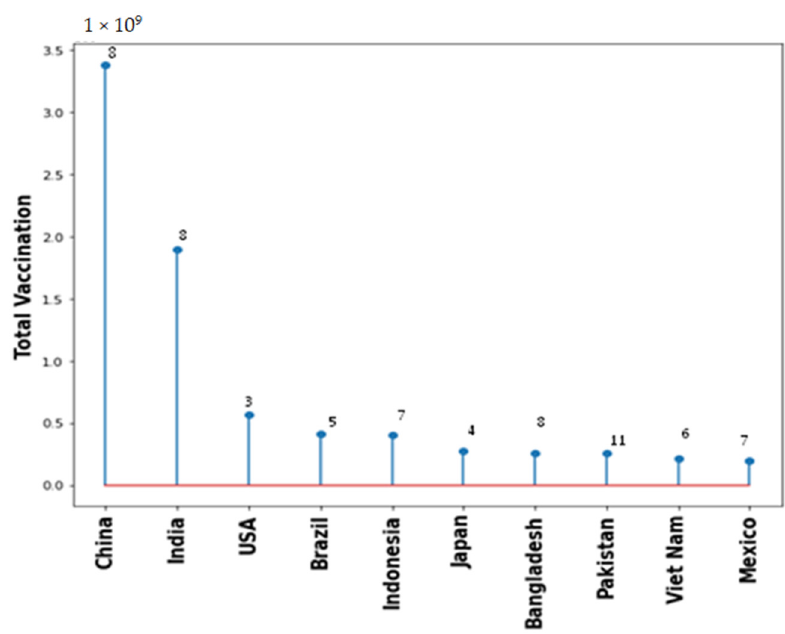
Figure 6. Total vaccination for the top 10 countries with number of types of different vaccine used.